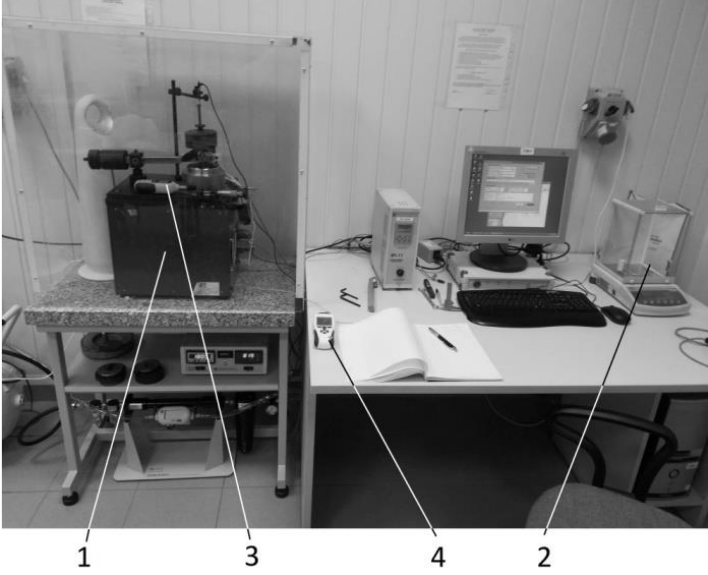
Figure 2. Test station: 1 —T-11 tribological tester; 2 —RADWAG WAS 160/C/2O scale; 3 —MT886 hygrometer; 4 —Velleman DEM106 temperature sensor.